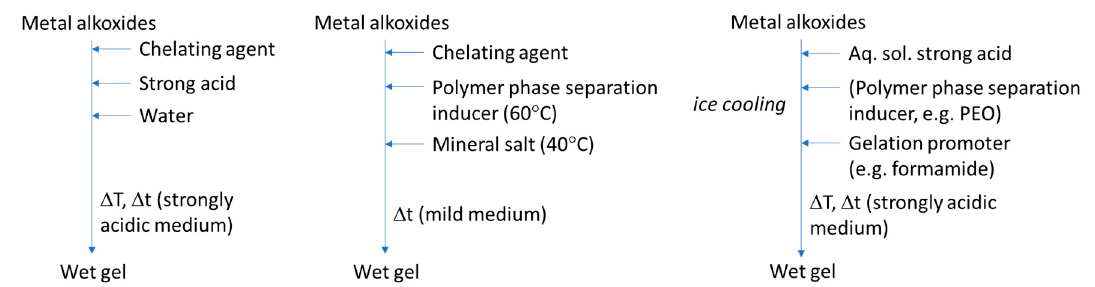
Figure 15. Representative synthesis schemes, where metal alkoxides are employed, showing specific variations for the achievement of macroporous monoliths of non-siliceous oxide composition, based on the sol-gel/phase separation method (Marques et al., original schemes).